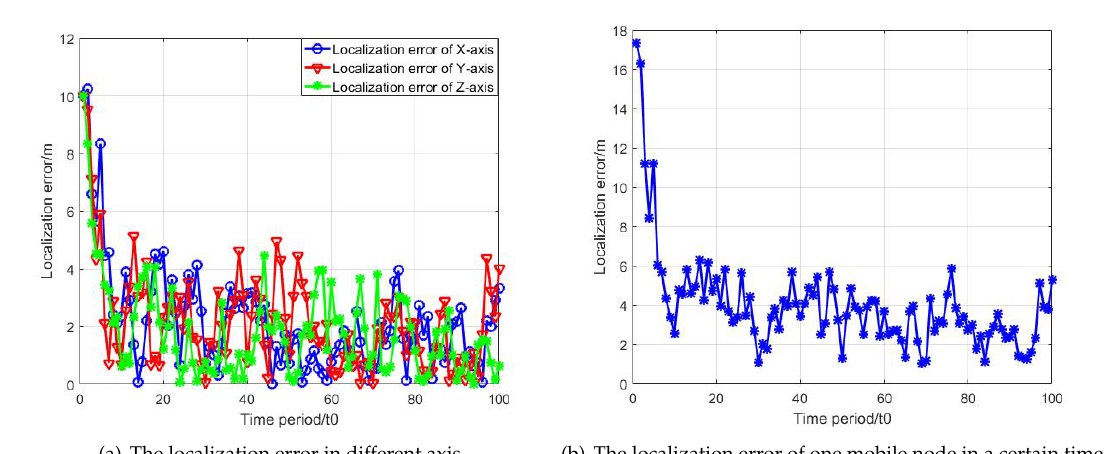
Figure 11. The Localization error analysis.